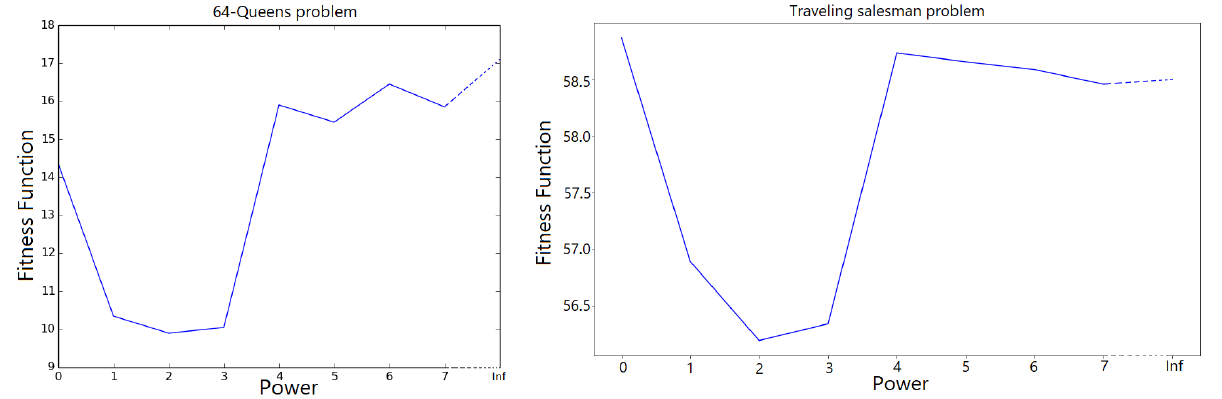
Figure 8. The fitness value of the best optimal solution for 64-Queens problem and TSP problem respectively as a function of Powers Pow where we averaged out ten runs. It starts with uniform distribution then uses a logarithmic scale of Pow , and end up with L-infinite norm. We have achieved similar results with two separate